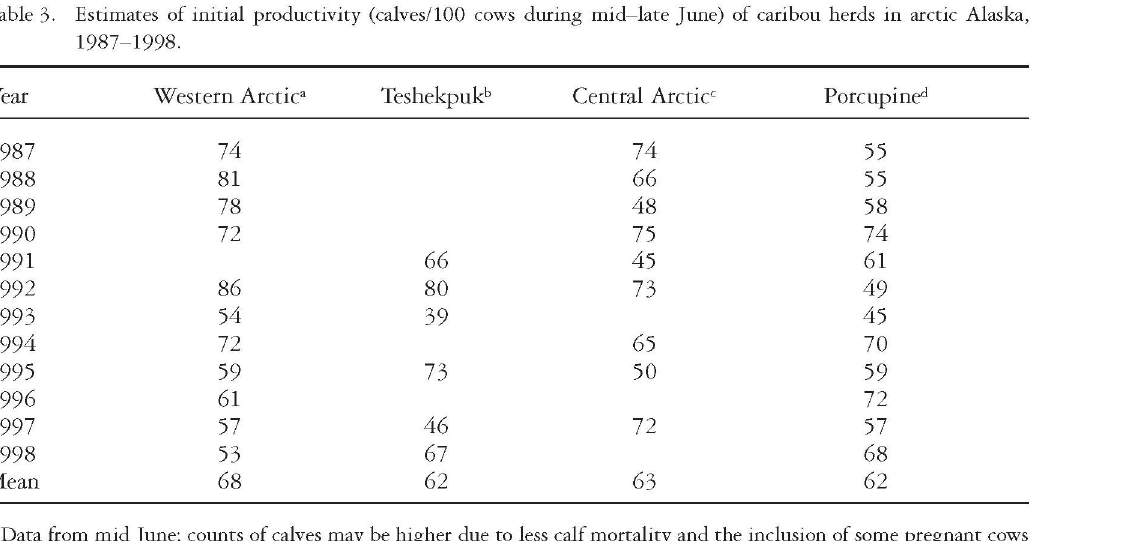
Table 3. Estimates of initial productivity (calves/100 cows during mid-late June) of caribou herds in arctic Alaska,